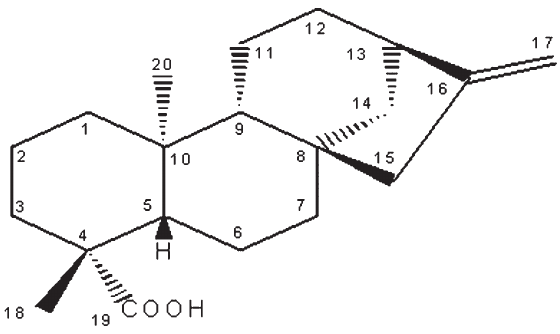
Figure 1. Structure of ent -kaur-16-en-19-oic acid (kaurenoic acid,